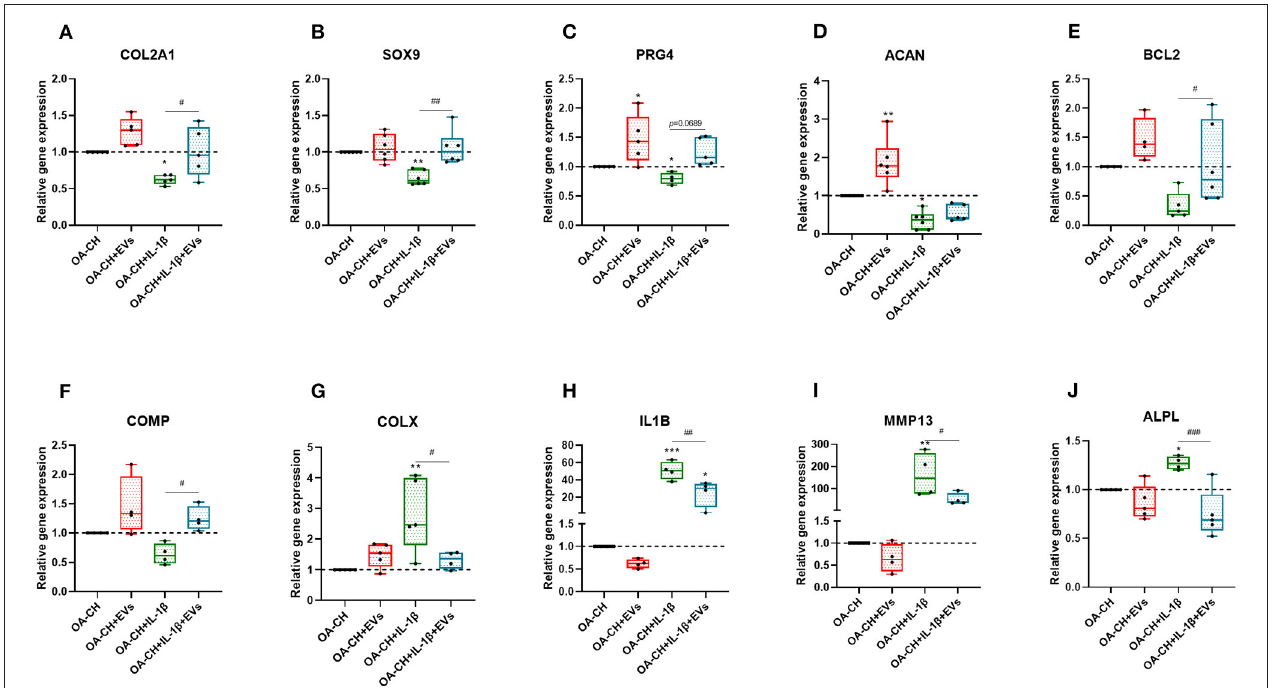
FIGURE 6 | hBMSC-EV effect on gene expression of anabolic and catabolic genes. (A–F) After 24h treatment with IL-1 β and/or hBMSC-EVs, gene expression levels of COL2A1, SOX9, PRG4, ACAN, BCL2, and COMP (anabolic) and COLX, IL1B, MMP13, and ALPL (catabolic) were determined using real-time PCR analysis (G–J) . All values represent mean ± standard deviation. *Significant difference to control (OA-CH): * p < 0.05; ** p < 0.01; *** p < 0.001; # significant difference between groups: # p < 0.05; ## p < 0.01; ### p < 0.001. One-way ANOVA with Newman–Keuls Multiple Comparison Test ( n = 4–6); EVs: